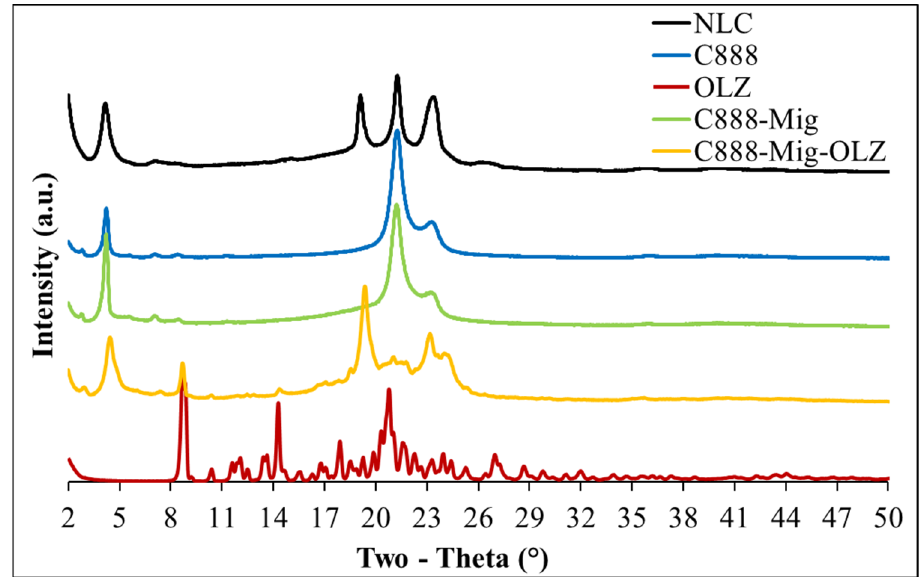
Figure 8. Diffractograms of OLZ-loaded NLCs, C888, OLZ, and physical mixtures (C-888-Mig and C888-Mig-OLZ).